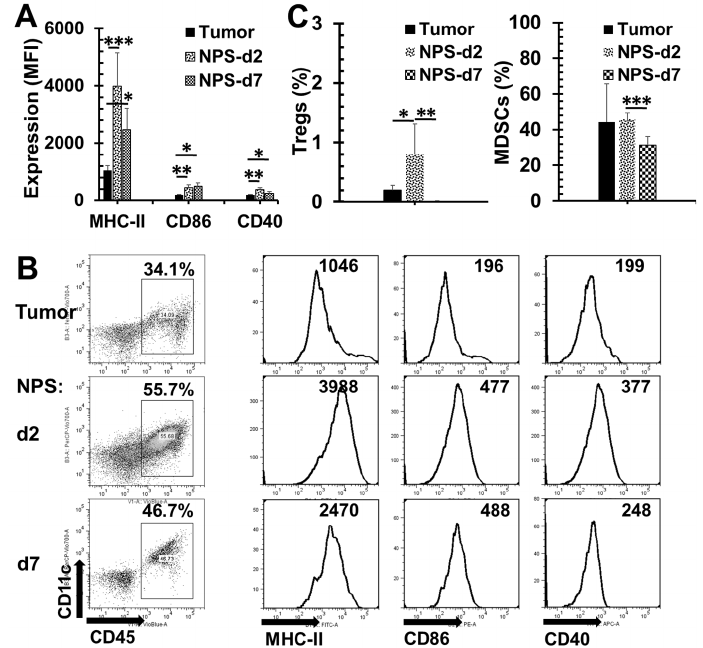
Figure 7. Activation of Dendritic cells (DCs) and changes of immune suppressor cells in tumor microenvironment (TME). Tumors were collected from tumor-bearing animals (tumor, n = 4), or animals treated with NPS on day 2 (NPS-2, n = 5) or day 7 (NPS-7, n = 5) post-treatment. Single cell suspension of tumor tissue was prepared and analyzed for the activation marker expression of DCs ( A , B ) and the frequencies of Tregs and MDSCs ( C ) by flow cytometry. * p < 0.05, ** p < 0.01, *** p < 0.001 for NPS-2 or NPS-7 vs. tumor by One Way